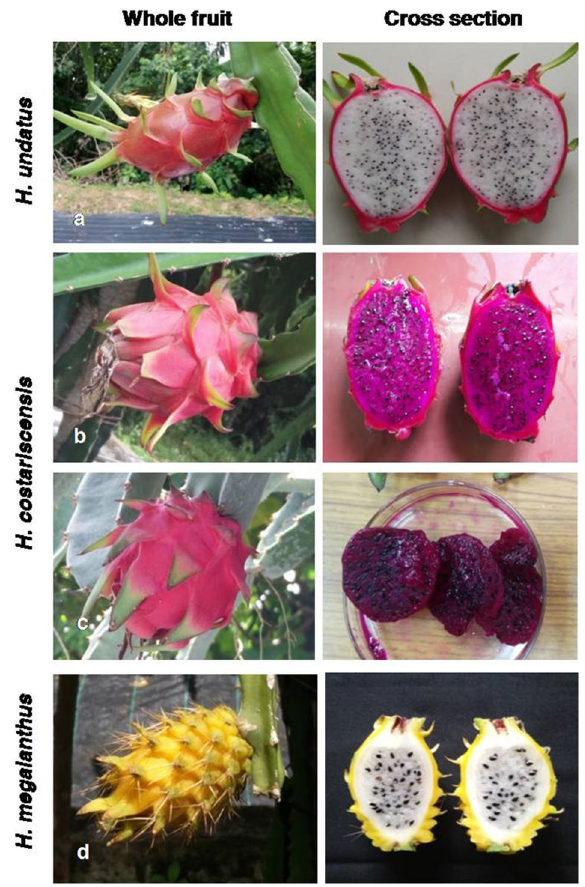
Figure 1. A characteristic fruit view of three different Hylocereus species of dragon fruit (1) H. undatus —DGF1 ( a ); (2) H. costariscensis —DGF2 ( b ), DGF4 ( c ) and (3) H. megalanthus —DGF3 ( d